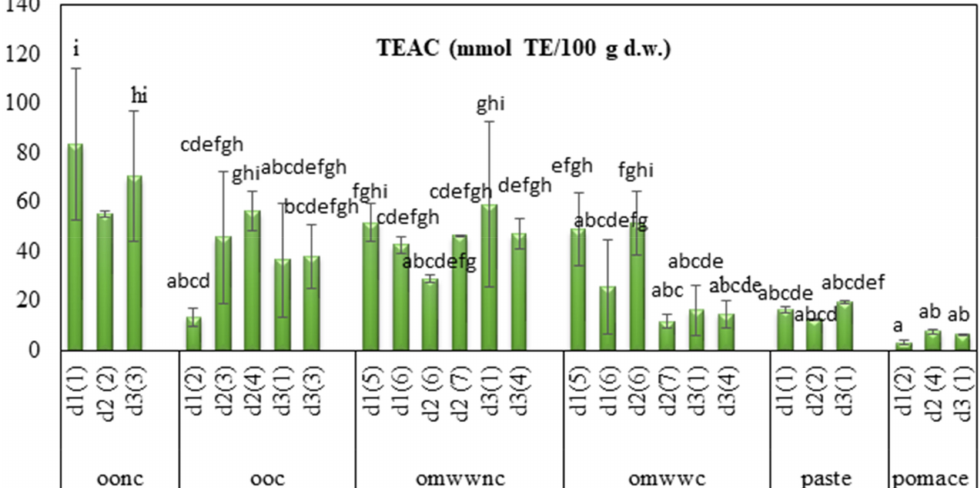
Figure 2. Trolox equivalent antioxidant capacity variation in olive oil, paste, and by-products. d1: 22 / 11 / 2017, d2: 19 / 12 / 2017, d3: 19 / 01 / 2018, oonc: Olive oil before vertical centrifugation, ooc: Olive oil after vertical centrifugation, omwwnc: Olive mill wastewater before vertical centrifugation, and omwwc: Olive mill wastewater after vertical centrifugation. (a-h) The di ff erent letters indicate a significant di ff erence (Duncan’s test, p < 0.05) values are expressed as mean values and standard deviations over three